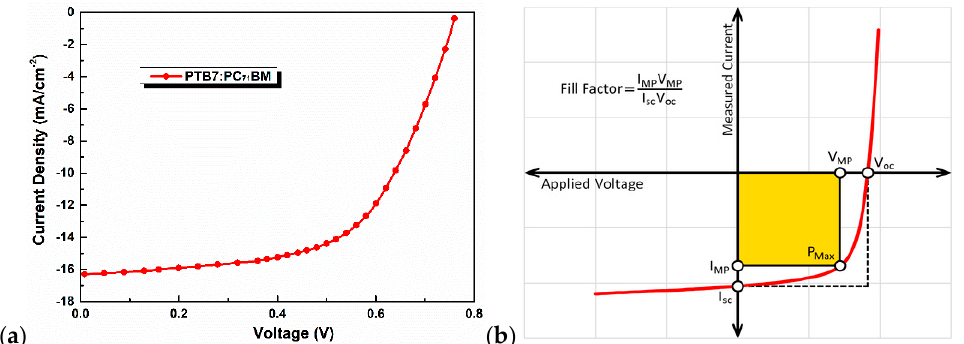
Figure 13. ( a ) J–V curve for organic photovoltaic device based on PTB7-PC 71 BM. ( b ) The fill factor demonstrated graphically on the J–V curve. Image remains the copyright of Ossila Ltd. Taken with permission from Ossila Ltd. [29].